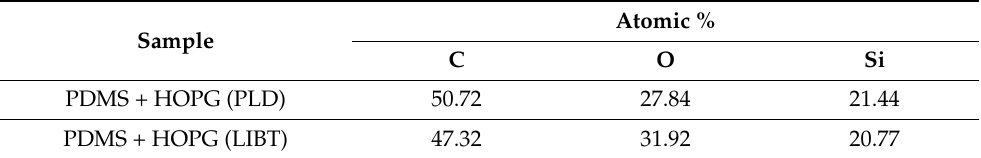
Table 2. The atomic percentage concentration of the individual elements of the coating layer formed on the surface of PDMS deposited by PLD and LIBT techniques is obtained by EDX.